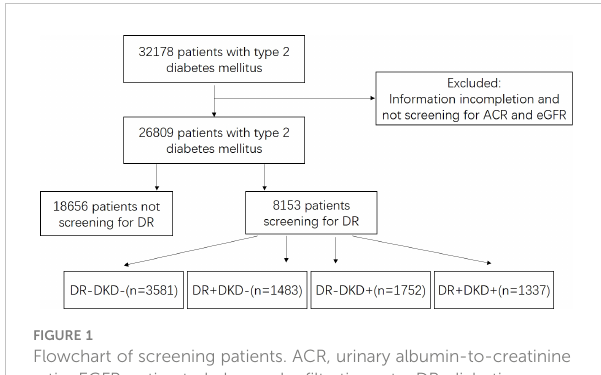
FIGURE 1 Flowchart of screening patients. ACR, urinary albumin-to-creatinine ratio. EGFR, estimated glomerular fi ltration rate. DR, diabetic retinopathy. “ + ” means positive, and “ - ” means